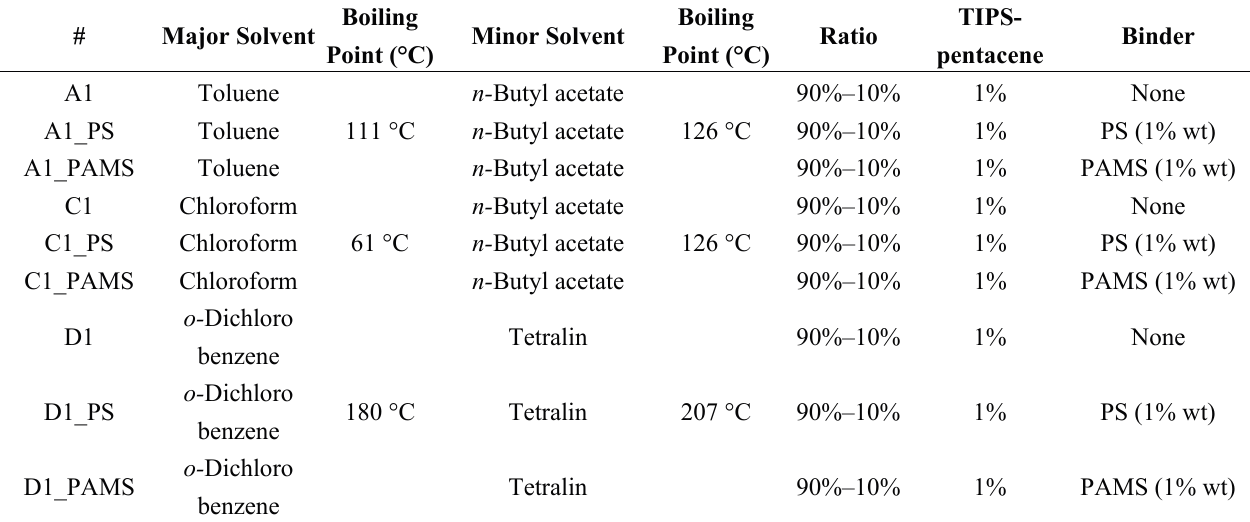
Table 3. List of the three sets of short listed solvent combinations for experimental part